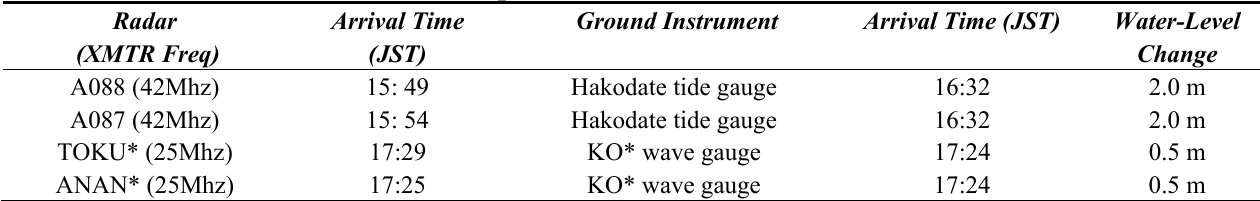
Table 1. Comparison of tsunami arrival times from radars and neighboring tide/wave